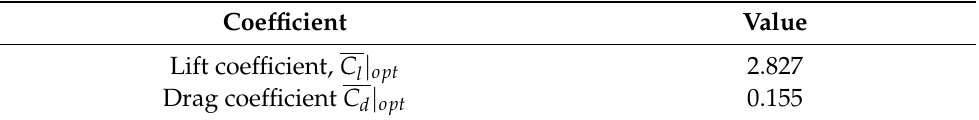
Table 7. Morphed airfoil mean lift and drag coefficients from the unsteady simulation.